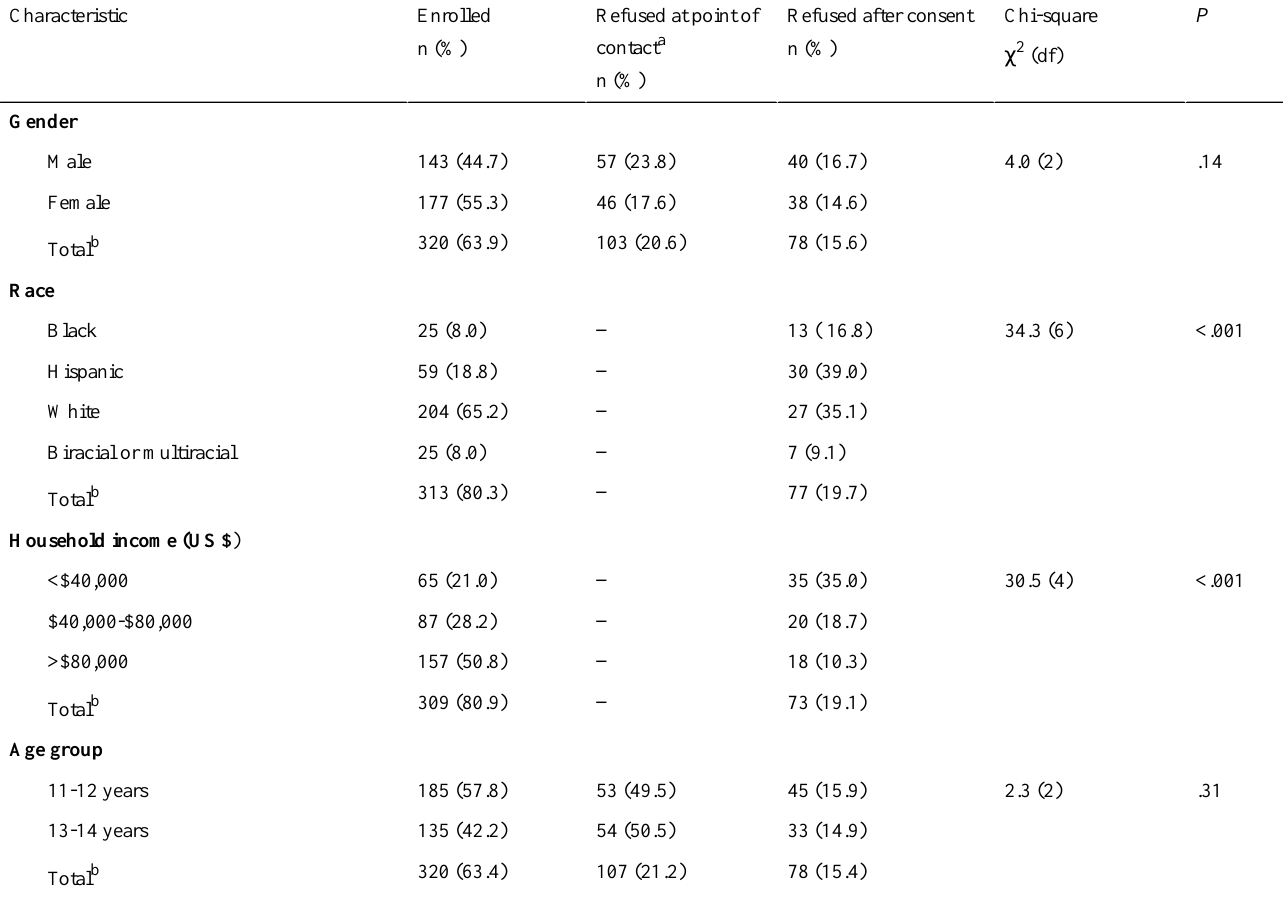
Table 2. Demographic differences by for participants who enrolled (n=320), those who refused at point of contact (n=112), and those who refused after consent (n=78) of the total 510 eligible youth who were approached to